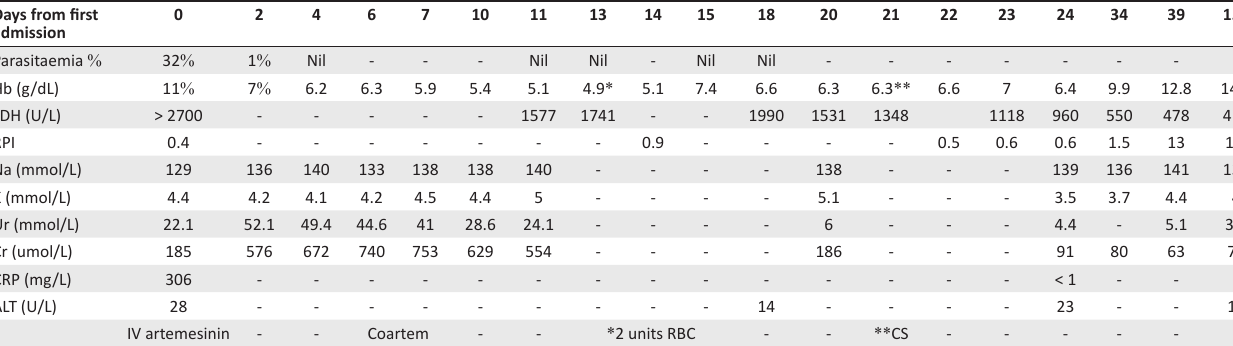
TABLE 1: Trends in key haematology and biochemistry blood results. Days from first